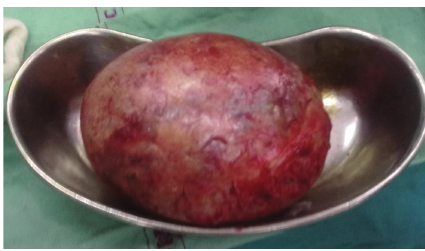
Figure 2: Completely removed Nabothian